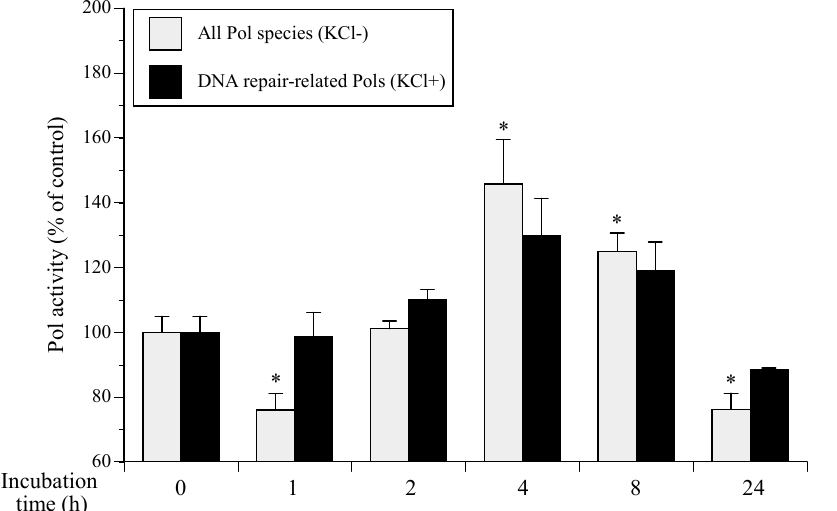
Figure 2. Pol activity depends on incubation time (1–24 h) in 100 mJ/cm 2 UVB-exposed NHEKs. Gray bars represent human whole Pol (standard reaction conditions without 120 mM KCl) and black bars represent DNA repair-related Pol species (with 120 mM KCl), respectively. Pol activity of vehicle control without UVB irradiation was arbitrarily designated 100%. All data are the mean ± SEM ( n = 3). * p < 0.05 with the UVB ( − ) vehicle control.